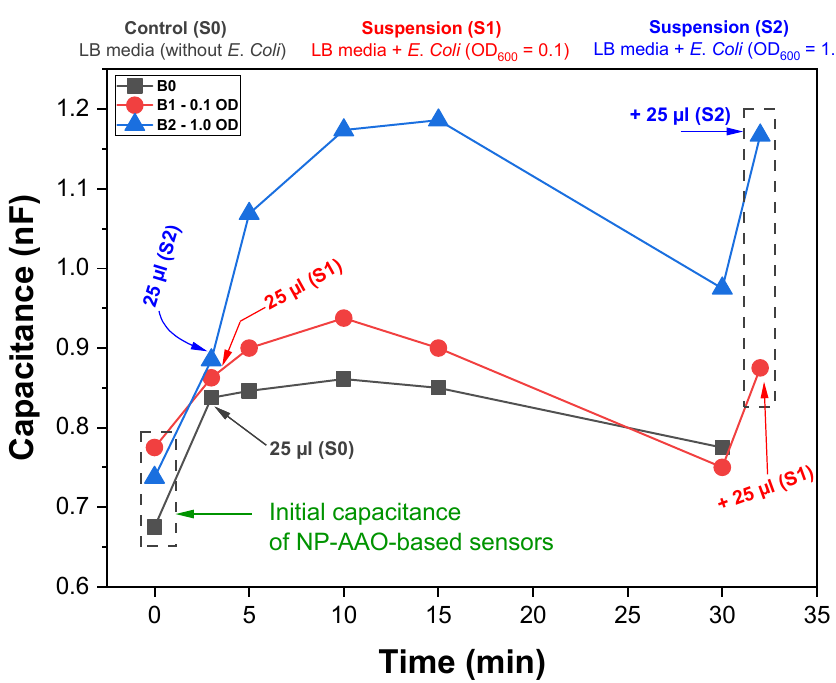
Figure 13. Capacitance variations along time for the NP-AAO touch sensors due to the contact with a suspension of Escherichia Coli bacteria.